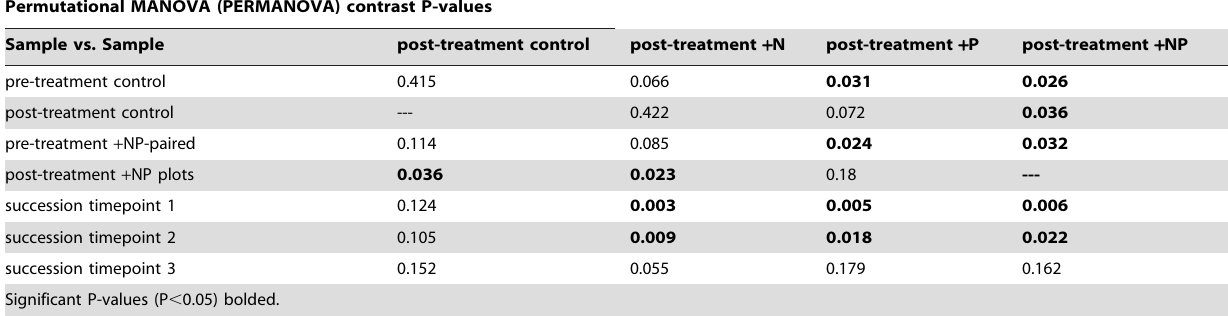
Table 1. Post-treatment + NP phylogenetic community structure was significantly different from controls and from all communities from the reference chronosequence with the exception of communities in the oldest soils (P , 0.05).